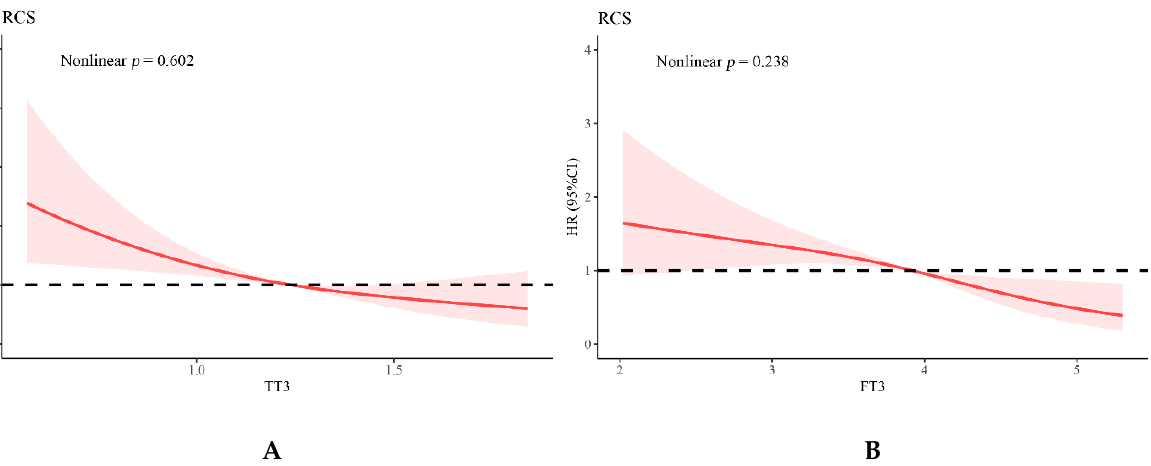
Figure 4. Cubic spline depicting the association of T3 with the incidence of composite of all ‐ cause mortality or rehospitalization for heart failure (adjusted for age, sex, Amiodarone use, BMI, and LVEF). ( A ). TT3, p for non ‐ linear = 0.602, p ‐ overall < 0.0001; ( B ). FT3, p for non ‐ linear = 0.238, p ‐ overall < 0.0001. Abbreviations: TT3, Total triiodothyronine; FT3, Free triiodothyronine; BMI, Body mass index; LVEF, Left ventricular ejection fraction.